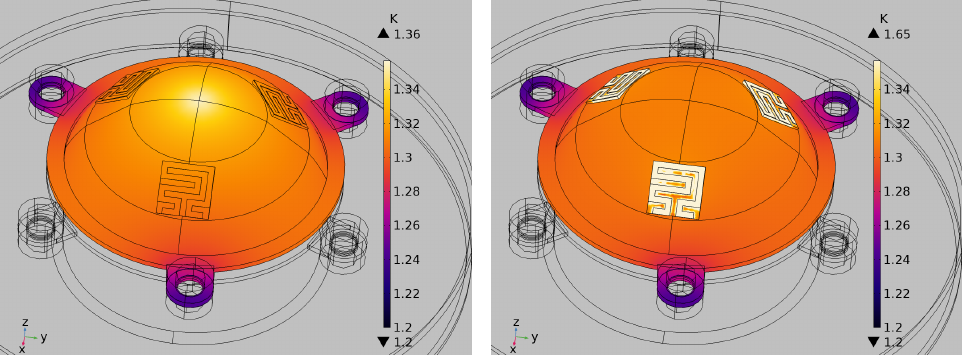
Figure 6. Temperature distribution inside the cavity, resulting from simulated Solar radiation ( left ) and from electrical heating ( right ), with the same power of 27